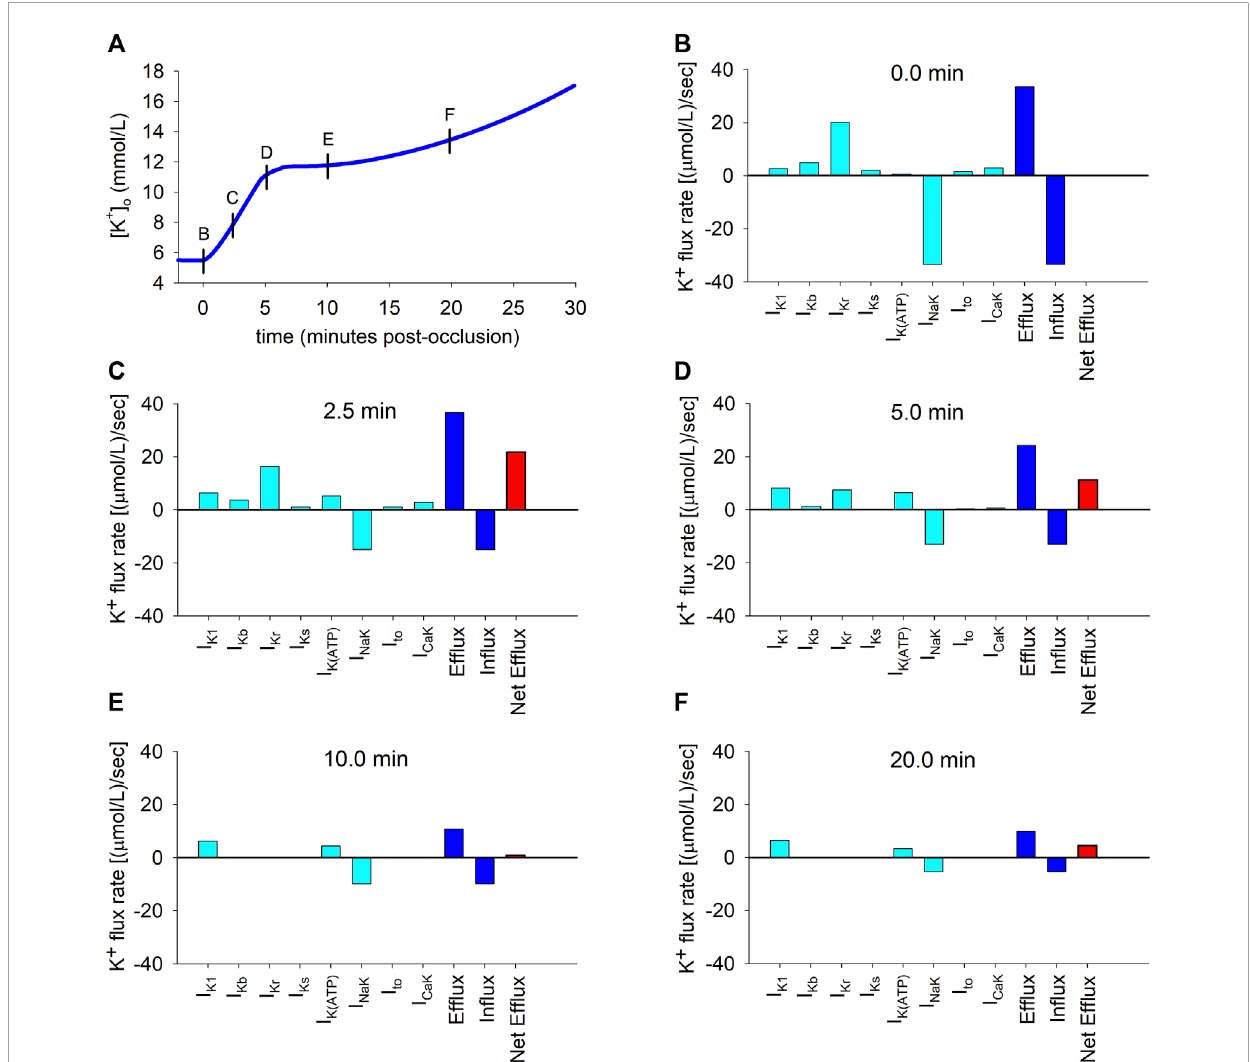
FIGURE 3 Potassium transmembrane fluxes carried by individual ionic currents. (A) : Simulated ischemic [ K + ] o vs. time in an isolated ventricular cardiomyocyte. (B–F) : Individual contributions of potassium currents to potassium transmembrane flux rates. Cyan coloured bars indicate efflux rates (when positive) or influx rates (when negative). Blue bars show total efflux and influx rates. Red bar indicates net efflux rate.